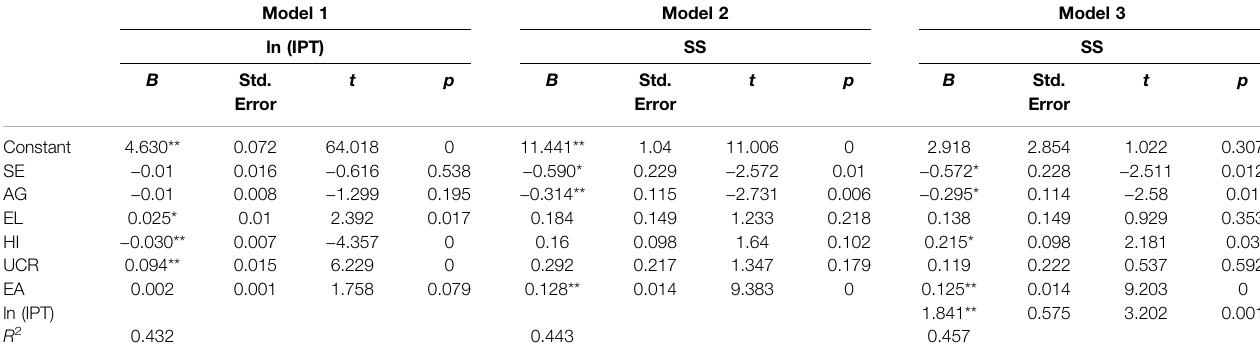
TABLE 7 | Stepwise regression.